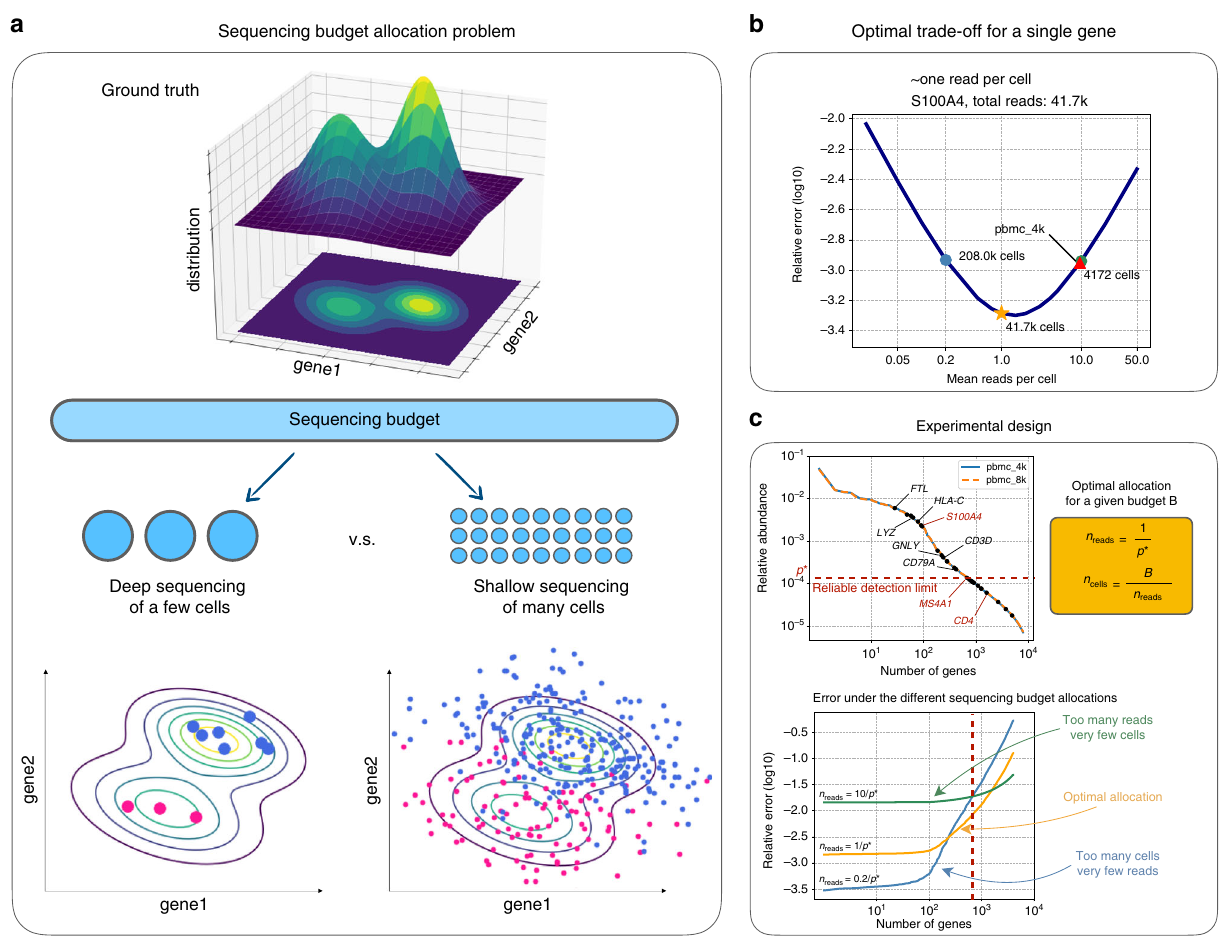
Fig. 1 Optimal sequencing budget allocation. a Description of the sequencing budget allocation problem. Consider estimating the underlying gene distribution (top) from the noisy read counts obtained via sequencing (bottom). With a fi xed number of reads to be sequenced, deep sequencing of a few cells accurately estimates each individual cell but lacks coverage of the entire distribution (left), whereas a shallow sequencing of many cells covers the entire population but introduces a lot of noise (right). b Optimal tradeoff. The memory T-cell marker gene S100A4 has 41.7k reads in the pbmc_4k (cid:4) Gamma ð r ; θ Þ , the relative error is plotted as a function of the sequencing depth, where dataset. For estimating the underlying gamma distribution X g g g the optimal error is obtained at a depth of one read per cell (orange star) and is two times smaller than that at the current depth of pbmc_4k (red triangle). c Experimental design. To determine the sequencing depth for an experiment, fi rst the relative gene expression level can be obtained via pilot experiments or previous studies (top left). Then the researcher can select a set of genes of interest (i.e., some marker genes highlighted as black dots), of which the ¼ 1 = p (cid:5) (top smallest relative expression level p (cid:5) ( MS4A1 ) de fi nes the reliable detection limit. Finally, the optimal sequencing depth is determined as n (cid:5) reads right). The errors under different tradeoffs are visualized as a function of the genes ordered from the most expressed to the least (bottom). The optimal sequencing budget allocation (orange) minimizes the worst-case error over all the genes of interest (left of the red dashed line), whereas both the deeper sequencing (green) and the shallower sequencing (blue) yield worse